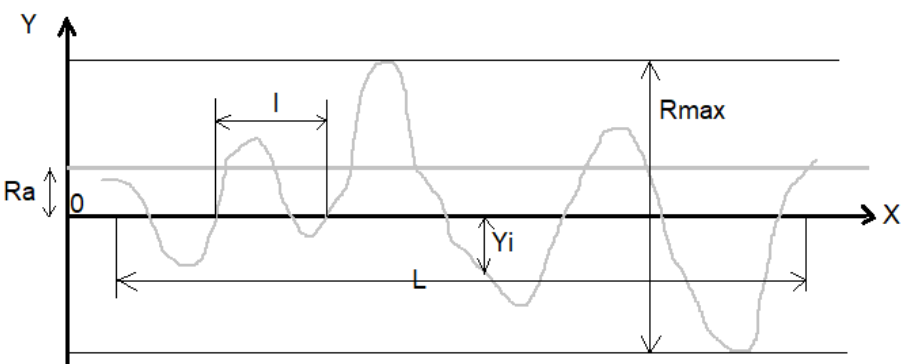
Figure 1. Surface roughness profile: yi is the vertical distance from the mean line to a given data point along the profile line; l is the mean width of the profile line.